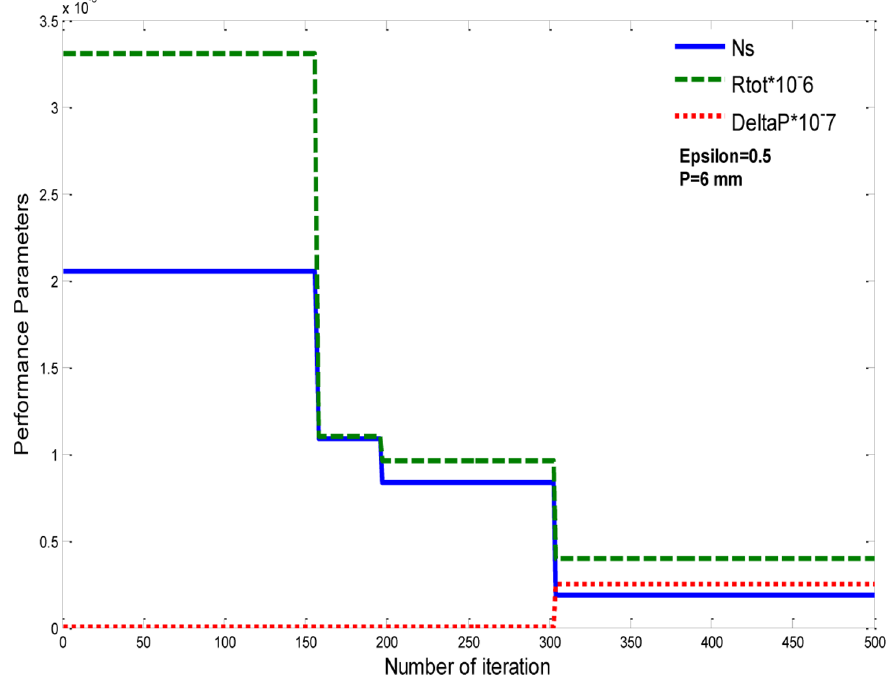
Figure 8. Variation of Ns, R tot , and D P for fixed values of P and e .